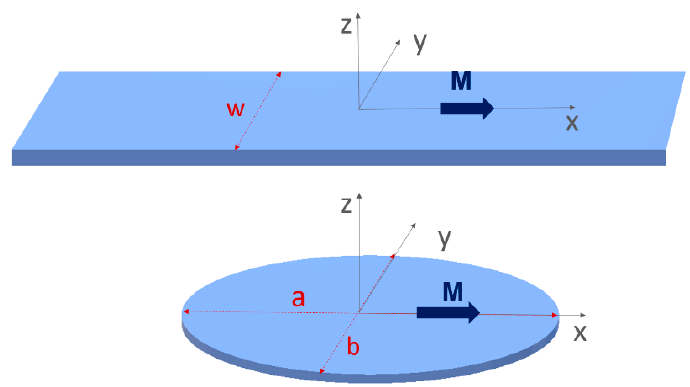
Figure 1. Sketch of the isolated nanoelements and of the reference frame considered in the present study: long wires and elliptical dots magnetized in-plane along the easy direction, coincident with the x-axis. The z-axis is perpendicular to the plane. The Micromagnetic simulations were performed by the GPU-accelerated software Mumax3 [27]. For the isolated stripe of width w = 100 nm and thickness t = 1.5 nm, the simulated area was divided in 8 × 20 × 1 cells with a dimension of 5 × 5 × 1.5 nm 3 . The periodic boundary conditions were applied in the x-direction, which represent the easy axis along which it is magnetized, to reproduce the infinite length of the stripe, taking into account that we are looking for stationary eigenmodes, with a uniform profile along the stripe length. (Please note that use of the periodic boundary conditions in the x-direction insures that the static internal field is uniform, avoiding the inhomogeneity that would originate by edges orthogonal to the magnetization. In second place, this is important to reduce the number of cells in the simulation, reducing the computation power and the time of the simulations.) For the elliptical magnetic dots, we kept a thickness t =1.5 nm, but considered three different lateral sizes a × b, namely 100 × 50 nm 2 , 200 × 100 nm 2 and 300 × 150 nm 2 , as sketched in Figure 1. Moreover, in order to better mimic the round shape of the dot borders, the size of the discrete cells was reduced to 2 × 2 × 1.5 nm 3 . Both stripes and dots were saturated along their long axis (coincident with the x-direction) by an external field B 0 = µ 0 H 0 = 0.1 T. Then, spin waves were excited using a spatially uniform sinc-shaped field pulse, with an amplitude b z = 10 mT directed along the z axis, able to activate modes up 50 GHz. The fast Fourier-transform (FFT) of the temporal evolution of the out of plane average magnetization of the discrete cells was then performed to obtain the spectrum of the dynamic eigenmodes. In a second step of our simulations, a spatially uniform external field, oscillating at the frequency of each mode of the spectrum, was applied to visualize the spatial profile of each eigenmode. Please note that using this procedure, the observed modes are those whose average dynamical magnetization is different from zero, i.e., those that would be revealed in either a ferromagnetic resonance or a Brillouin light scattering experiment, while odd modes, having a negligible average value of the dynamical magnetization, are not included in our results. For both stripes and dots, magnetic parameters typical of CoB were assumed, i.e., saturation magnetization M s = 1.2 MA/m, exchange stiffness A = 10 pJ/m, which lead to a value of the exchange correlation length of about 3.3 nm. The Gilbert damping was fixed to α = 0.001, to obtain a narrow linewidth of the peaks in the eigenmodes